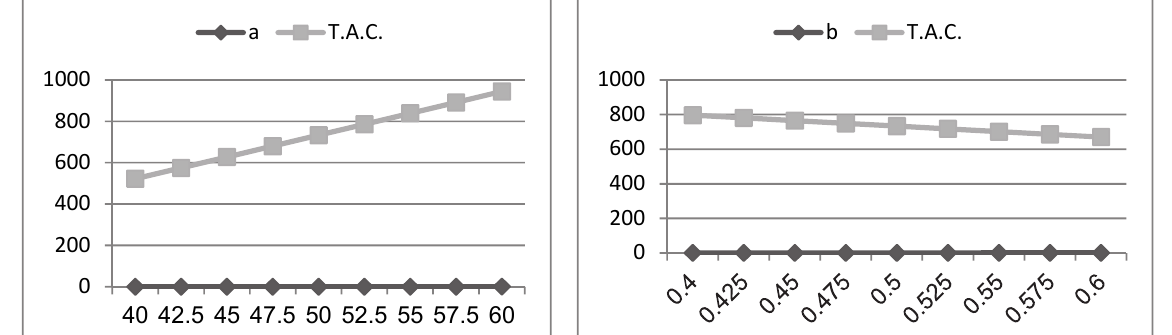
Fig. 3. Variation in total average cost w.r.t. Fig. 4. Variation in total average cost w.r.t.